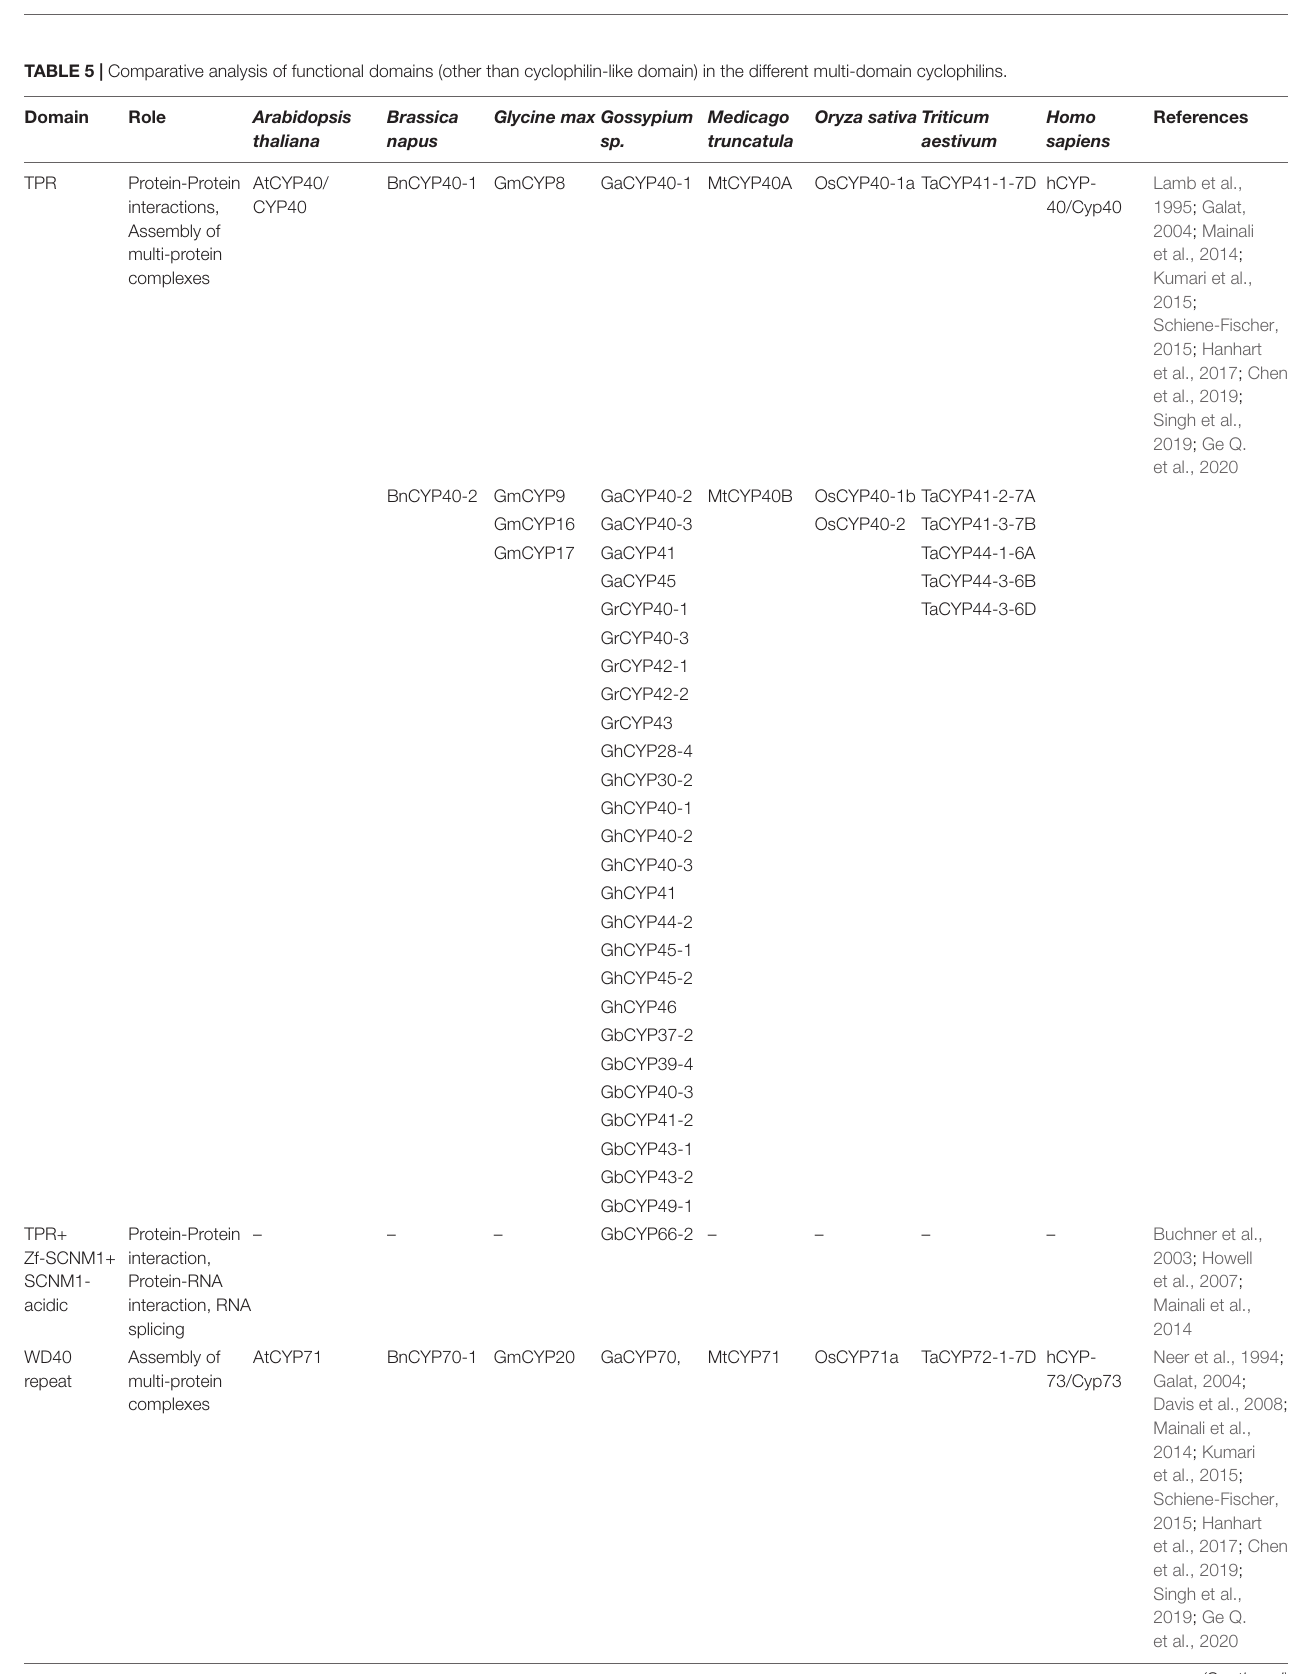
TABLE 5 | Comparative analysis of functional domains (other than cyclophilin-like domain) in the different multi-domain cyclophilins.